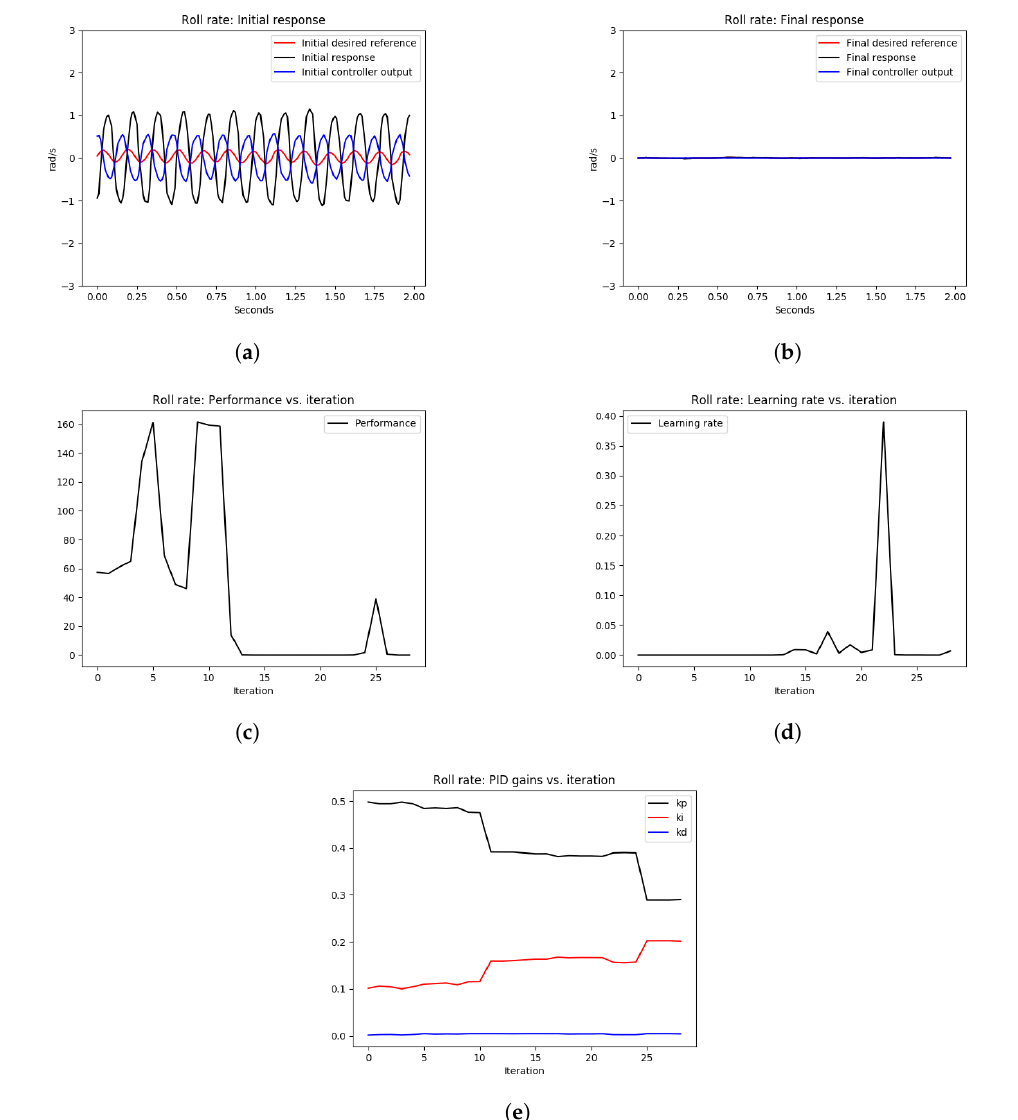
Figure 8. The tuning process of the roll-rate PID controller during hovering. The quadrotor starts with an oscillating behavior due to poorly tuned PID gains. Eventually, the angular rate loops are stabilized after the real-time tuning process. ( a ) signals before tuning, ( b ) signals after tuning, ( c ) performance error V ( E ) over iterations, ( d ) learning rate α over tuning iterations, ( e ) PID